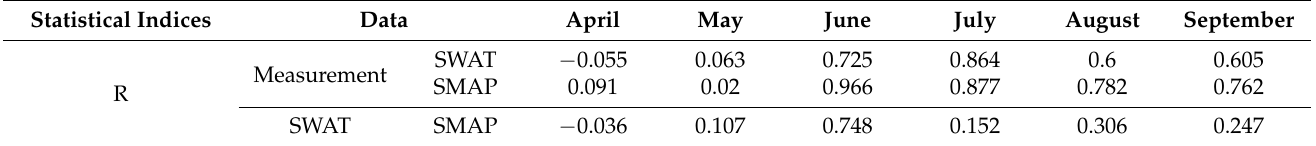
Table 4. Monthly statistical analysis between SWC